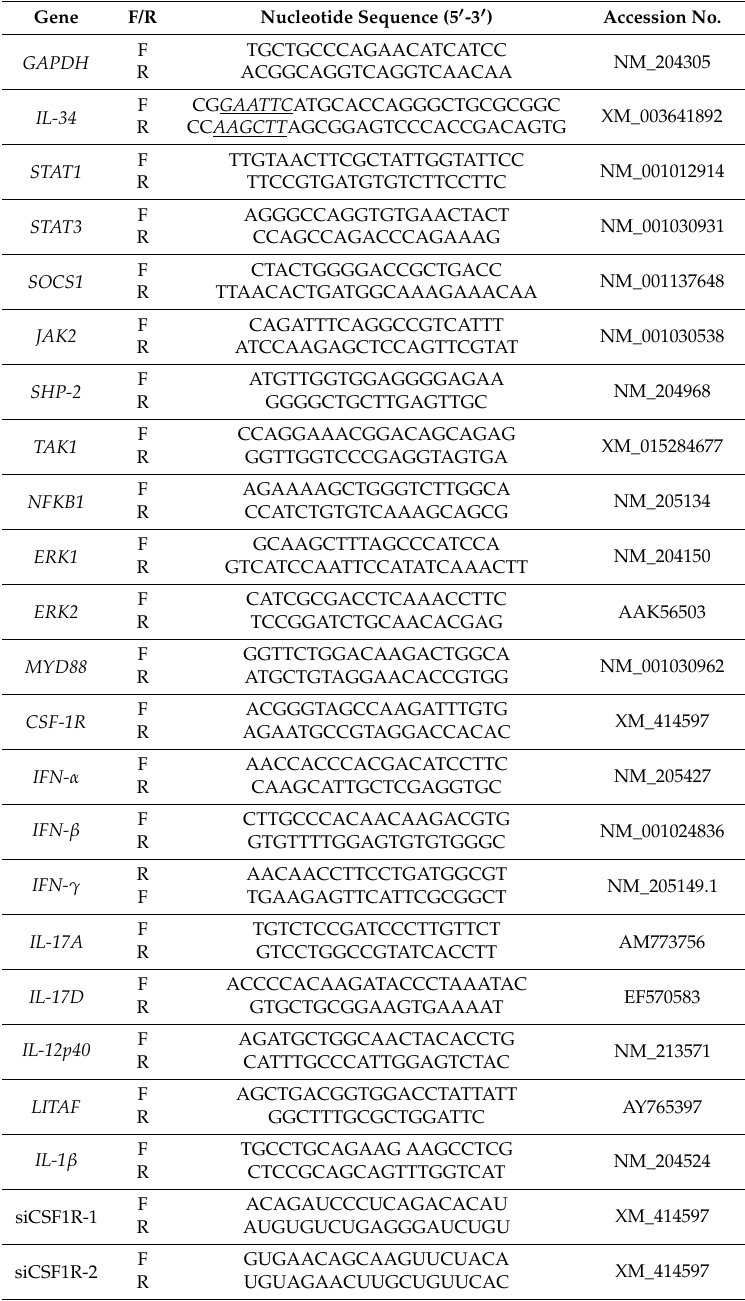
Table 3. Primer sequences for qRT-PCR analyses of gene expression